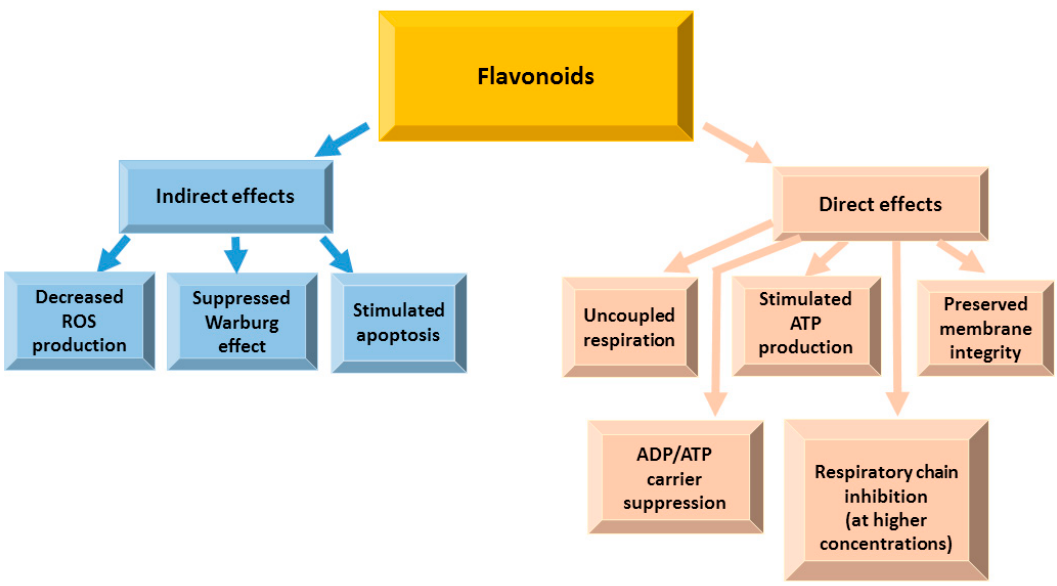
Figure 12. Indirect and direct e ff ects of flavonoids on mitochondrial functions.